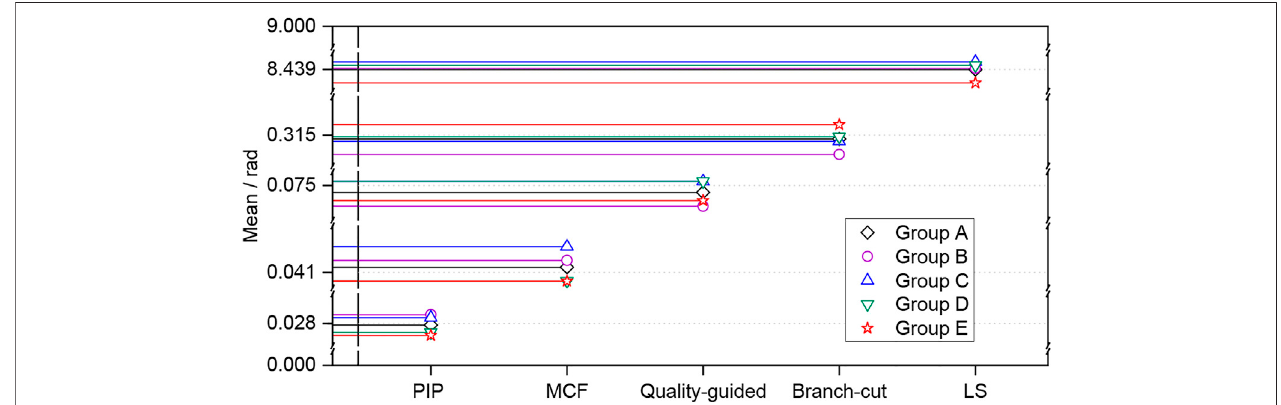
FIGURE 14 | Mean scatter plot for phase errors of fi ve groups of repeated experiments.